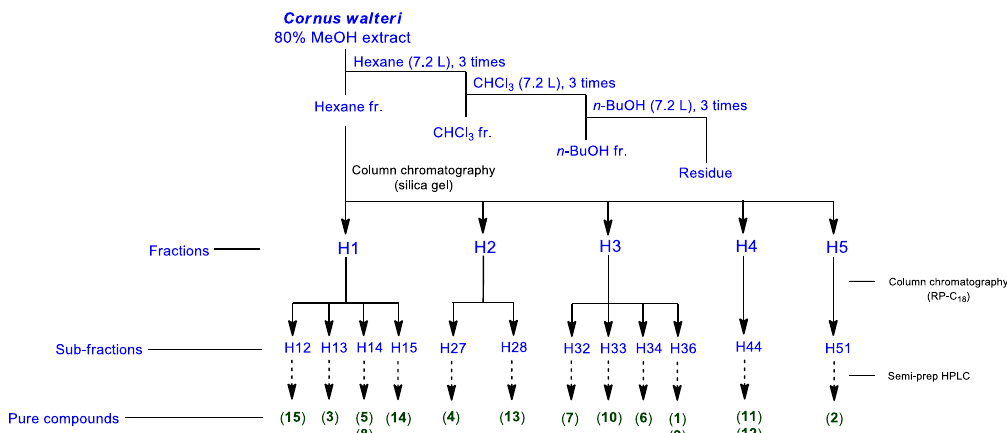
Figure 1. Separation scheme of compounds 1 – 15 . 5 α -Stigmast-3,6-dione ( 1 ), 3 β -sitostanol ( 2 ), 6 α -hydroxy- β -sitostenone ( 3 ), 6 β -hydroxysitostenone ( 4 ), norphytan ( 5 ), phytone ( 6 ), methyl 3- O -acetylbetulinate ( 7 ), 3- O -acetylbetulin ( 8 ), sitostenone ( 9 ), leucophyllone ( 10 ), lupeol ( 11 ), lupenone ( 12 ), betulinic acid ( 13 ), betulinic acid methyl ester ( 14 ), and benzyl salicylate ( 15 ). MeOH, methanol; BuOH, butanol; RP, reversed phase; HPLC, high-performance liquid chromatography.